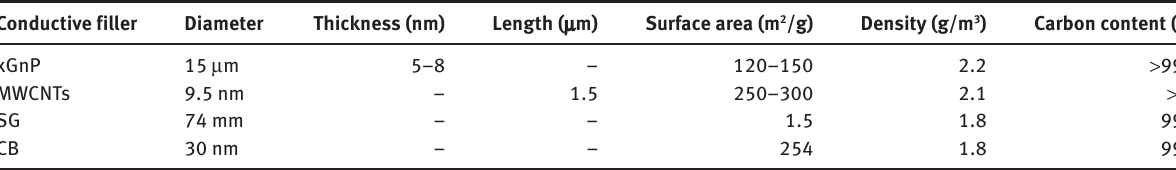
Table 1: The characteristics of the conductive fillers as received by the suppliers. Conductive